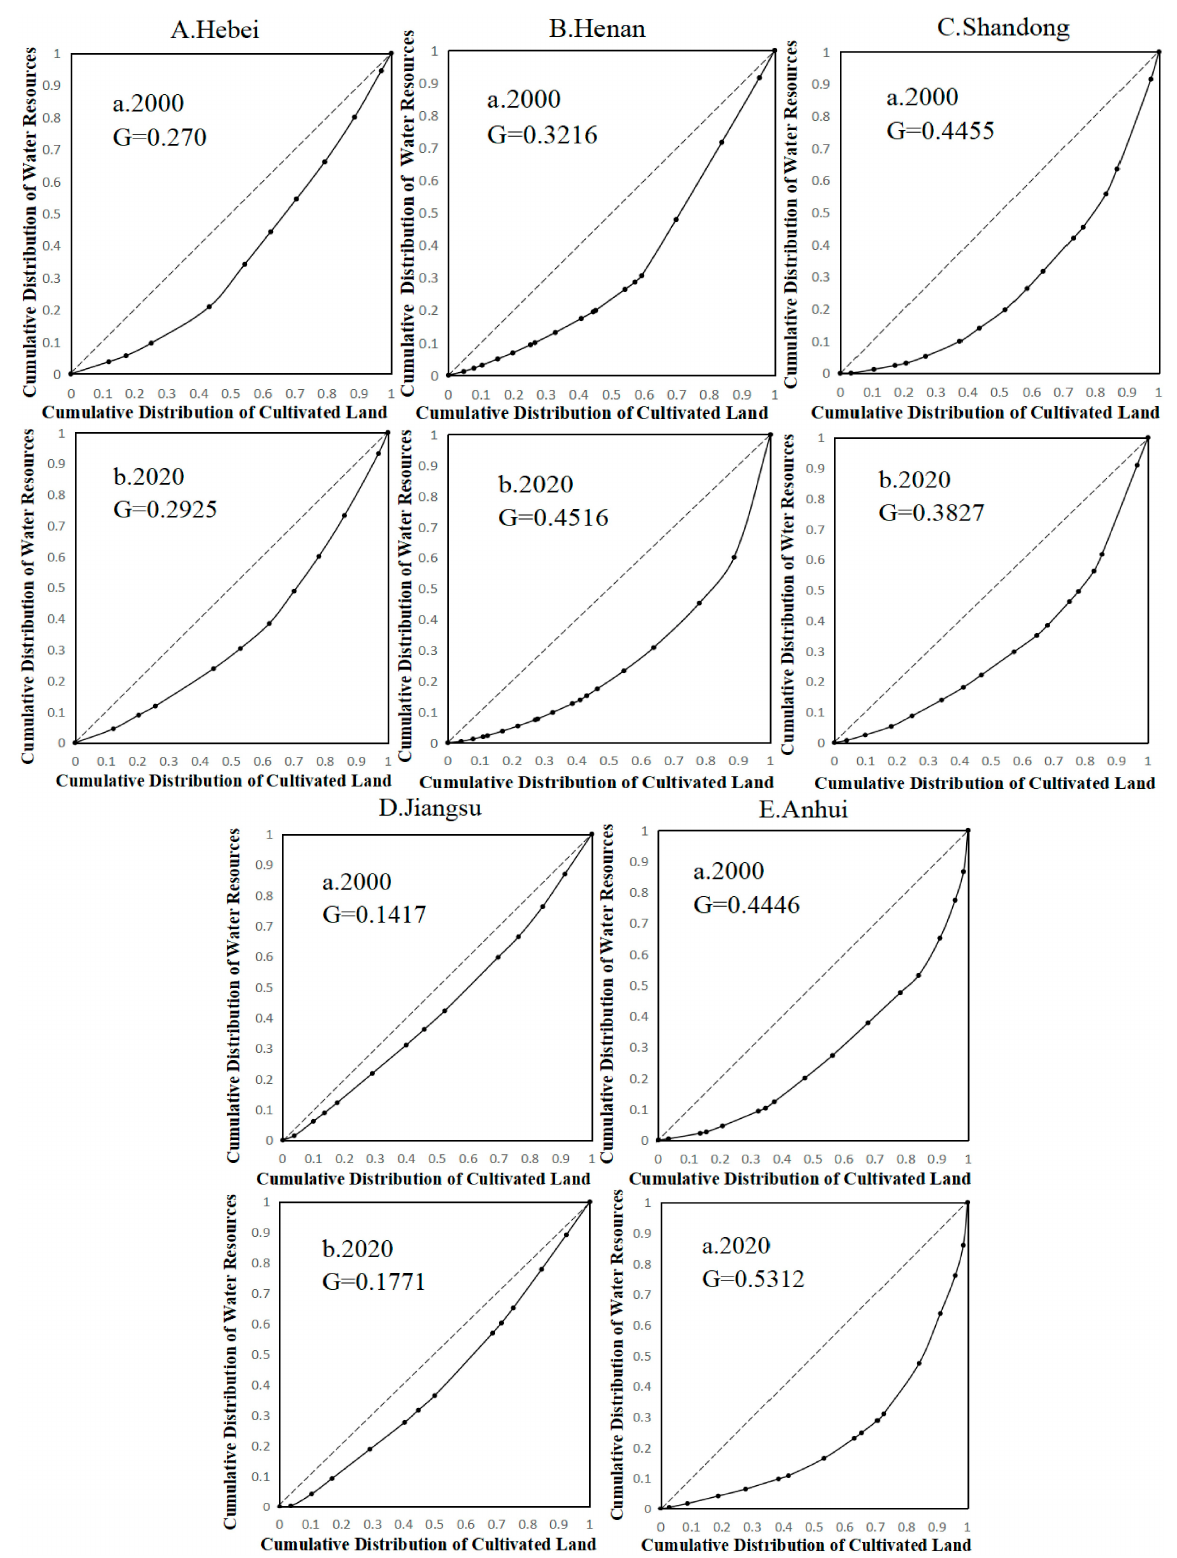
Figure 4. Lorentz curves of matching the amount of water available for food production with the cultivated land resources in Hebei ( A ), Henan ( B ), Shandong ( C ), Jiangsu ( D ), and Anhui ( E ) provinces. The dashed line is absolute average line.